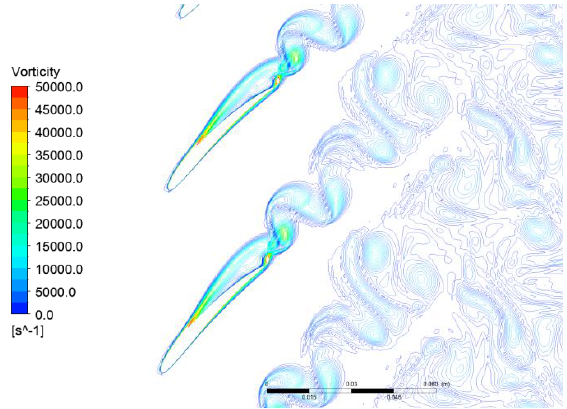
Figure 13. Effect of unsteady excitation at near stall point. 4.4. Response of Separation Flow under Unsteady Excitations For the traditional method to control the separation of flow field, it was common to excite the separated flow with the frequency of shedding vortices. Under this condition the working range and total performance of the stage also had been improved, which had been widely investigated by researchers [9–13]. In this section, the excitation by the frequency of shedding vortices on the separation flow was also conducted. As Figure 13 indicated, positive effects were indeed obtained on the control of separation flow at a range of ±12.5% around F shed. As shown in Figure 14, the structure of the vortex under excitation was similar to the initial state, which was presented in Figure 6 without excitation. From the total pressure distribution in Figure 15, the separation zone and total pressure loss were all reduced with the unsteady excitation at the frequency of 36 times the RF. The mechanism of this phenomenon was that periodic excitation rectified the separation flow and injected energy into the vortex shedding flow. While increasing the strength of shedding vortices, the separation flow on the suction side of blade was suppressed. Then